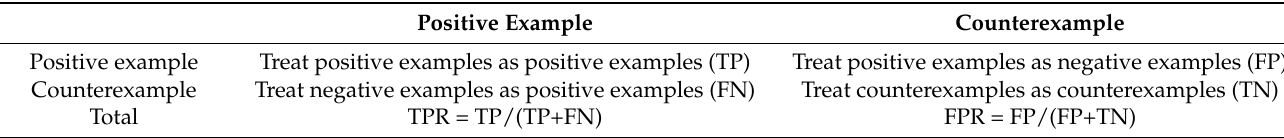
Table 1. Confusion matrix